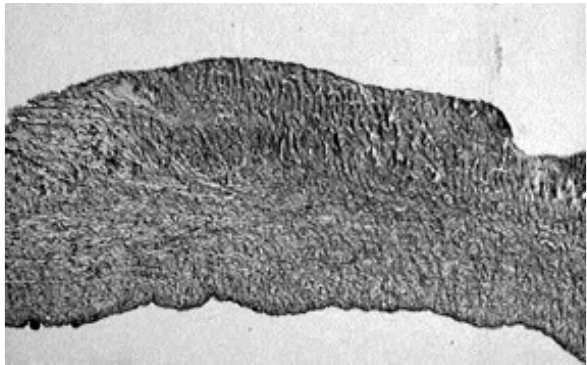
Fig. 1 - Fotomicrografia de heteroenxerto descelularizado. Observamos a matriz colágena intacta, com estrutura trilaminar presente, notando-se aumento do espaço entre as fibras colágenas. Coloração HE, aumento de